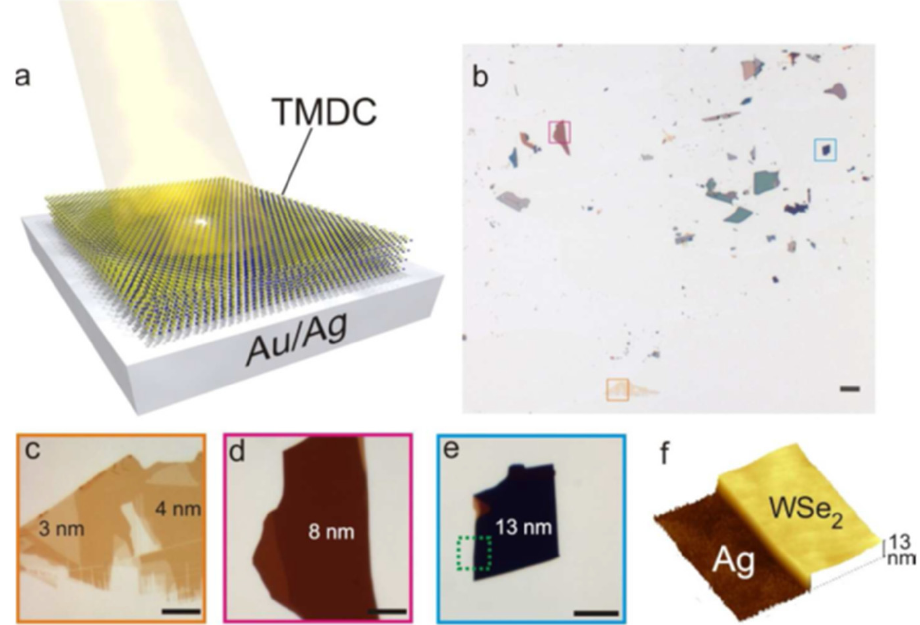
Figure 7. Absorbing TMD on metals: ( a ) Schematic diagram of a thin, multilayer TMDC film on an Au/Ag back reflecting substrate. ( b ) Low magnification optical micrograph of exfoliated WSe 2 flakes on template stripped Ag substrate. (Scale bar = 50 µ m) ( c – e ) High magnification micrographs of yellow, red, and blue square regions on ( b ) respectively with increasing flake thickness from ( c ) to ( e ). The sharp blue shift in color and rising contrast with increasing thickness can be seen (Scale bar = 10 µ m). ( f ) AFM topography of the flake region in ( e ). Reprinted (adapted) with permission from Reference [143], Copyright (2016), American Chemical Society.